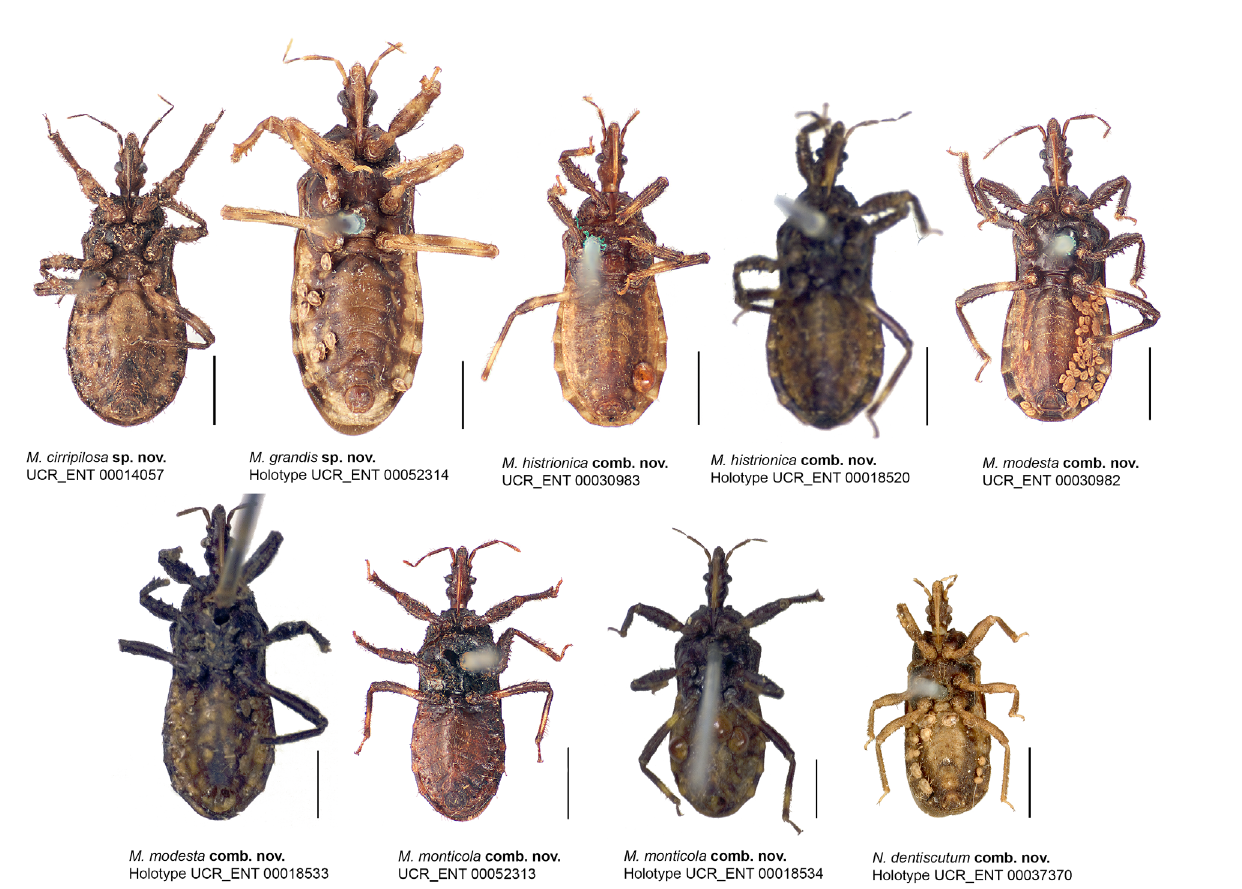
Fig. 11. Ventral habitus images for species of Macrophysoderes gen. nov. and Nanophysoderes gen. nov. Scale bars = 2